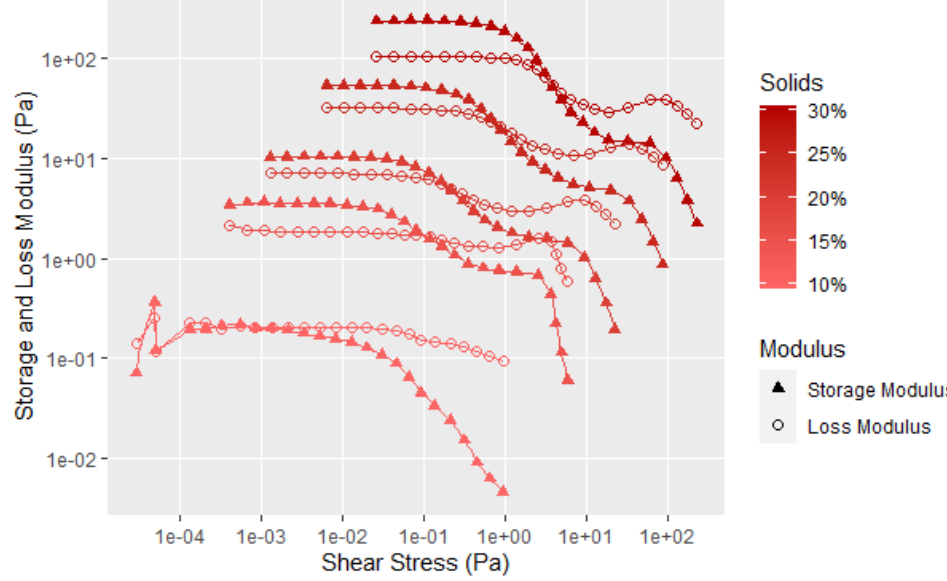
Figure 5. Averaged (3 replicates) amplitude sweep data for mixtures of 90 PDI flour with 1 h mixing time and varying solids content. Individual runs are shown in Figures A1–A5 (Appendix A).